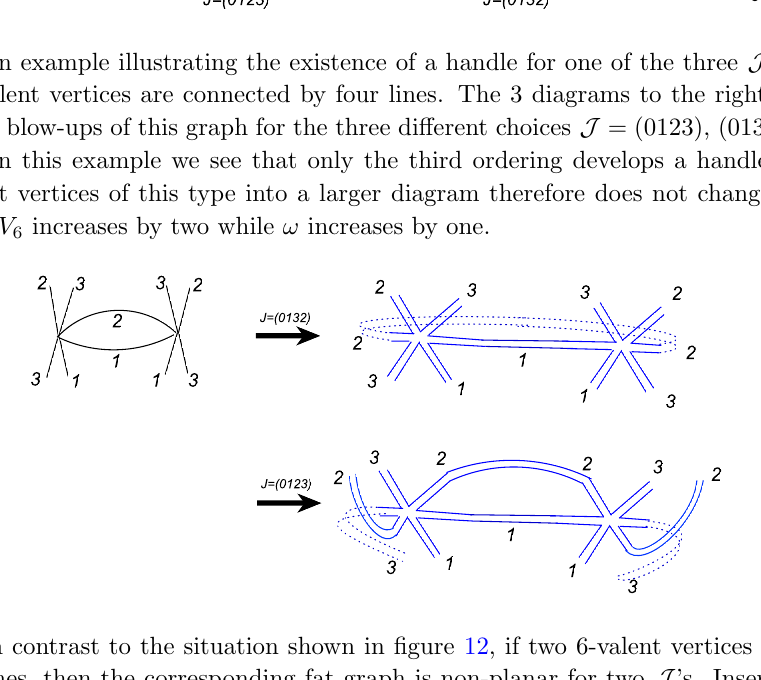
V 6 (cid:0) ! by one. 2